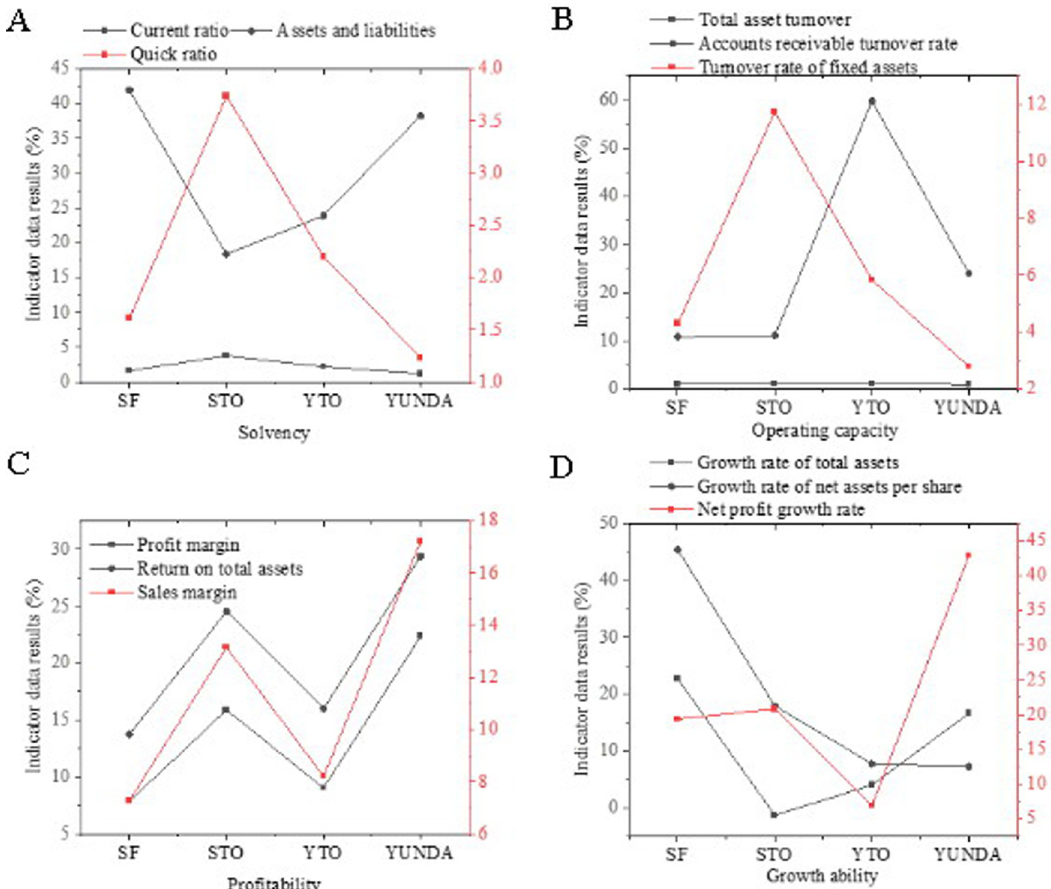
Fig 6. Comparison of horizontal capabilities of Chinese express enterprises in terms of financial